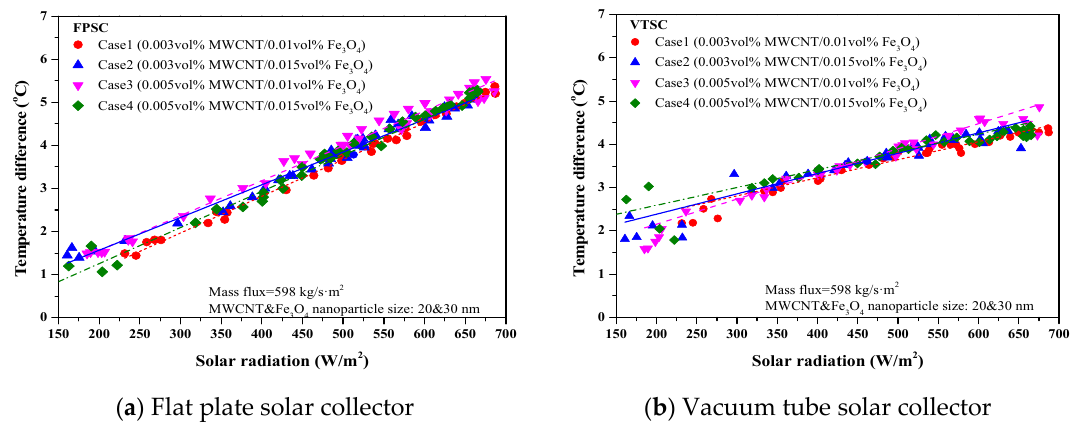
Figure 7. Variation of temperature difference in the flat plate and vacuum tube solar collector depending on solar radiation.